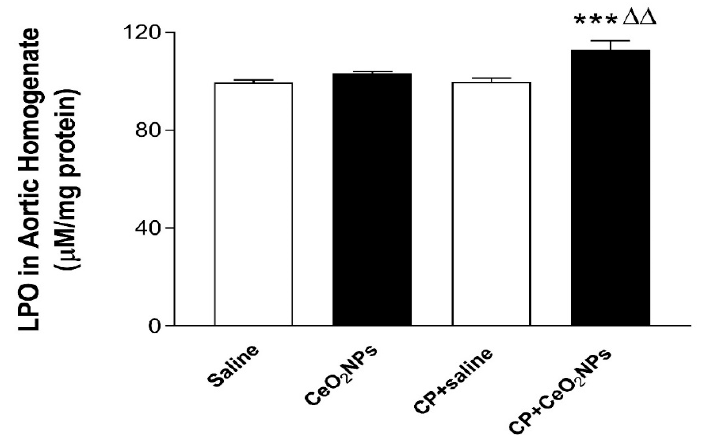
Figure 5. Aortic homogenates concentration of lipid peroxidation (LPO) in rats intratracheally instilled with either saline (control, n = 8) or cerium oxide nanoparticles (CeO 2 NPs, n = 7 ) with ( n = 8) or without ( n = 7) cisplatin (CP) administration. *** P < 0.001 compared with CP + saline-treated group. ΔΔ P < 0.01 compared with CeO 2 NPs-treated group. Data are mean ± SEM.